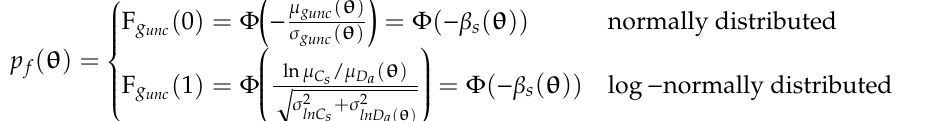
( θ ) follows a log-normal unc